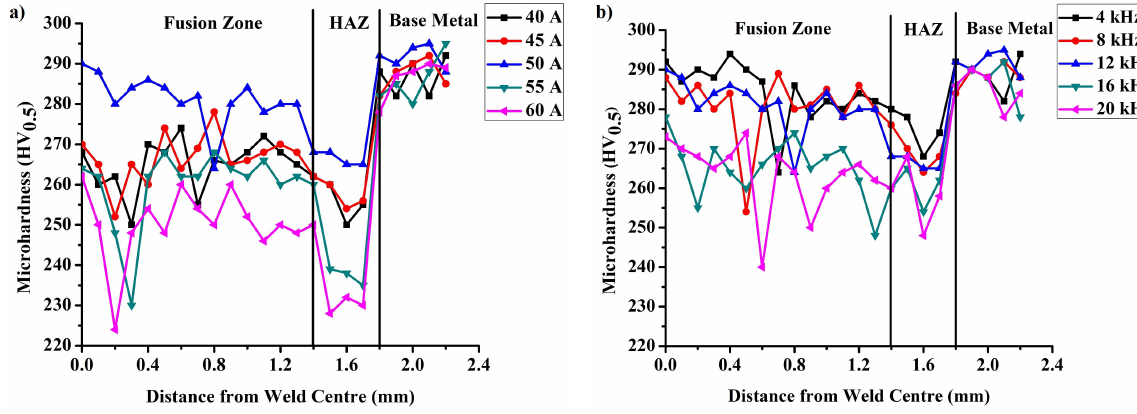
Figure 10: Microhardness variationacross the welded joint along the mid-thickness region at different levels of a) DC and b) DCF